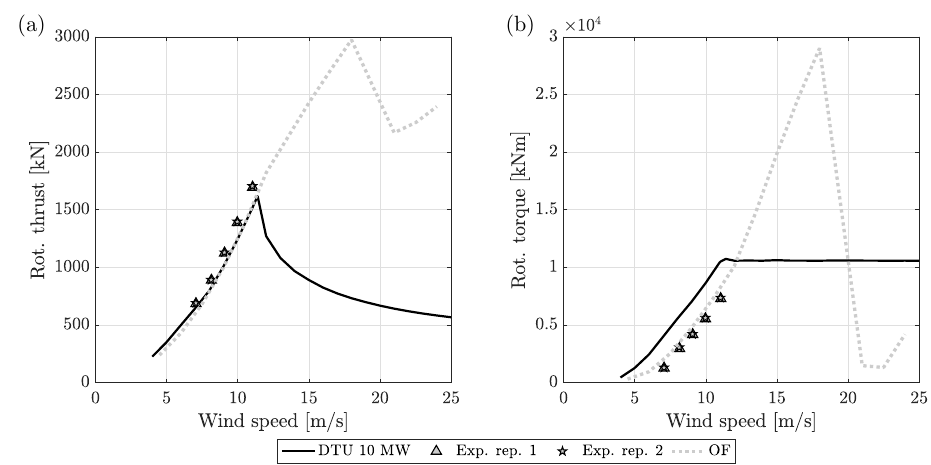
Figure 8. The steady-sate aerodynamic response of the wind turbine model and two wind tunnel runs (rep. 1, rep. 2) is compared at full-scale to the DTU 10 MW and to predictions obtained with the OpenFAST (OF) model of the scale model turbine. ( a ) Rotor thrust. ( b ) Rotor